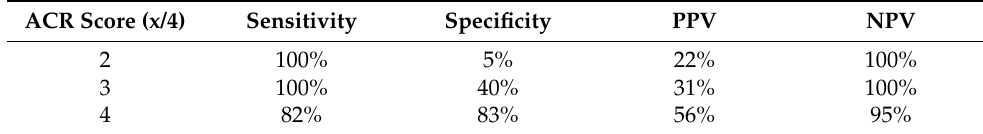
Table 6. Performance scores for ACR (pre-test) and TAB. Table 8. Performance scores for ACR and TAB.